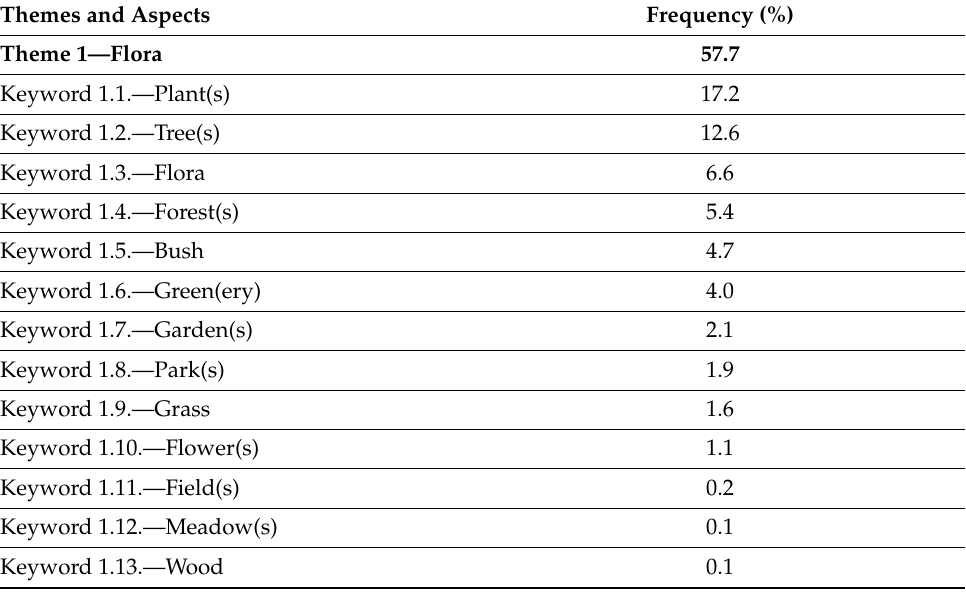
Table 2. Conceptions of ‘nature’—associations. Frequency reflects the percentage of respondents who referenced each theme/category. N.B the total(s) add up to over 100.0 percent because respondents often referenced more than one